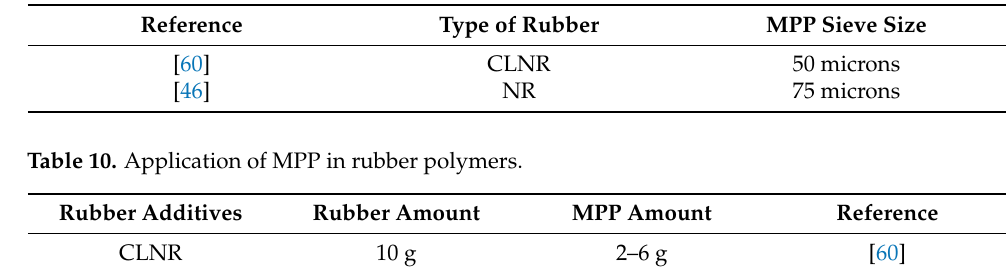
Table 9. Application of MPP based on previous studies.